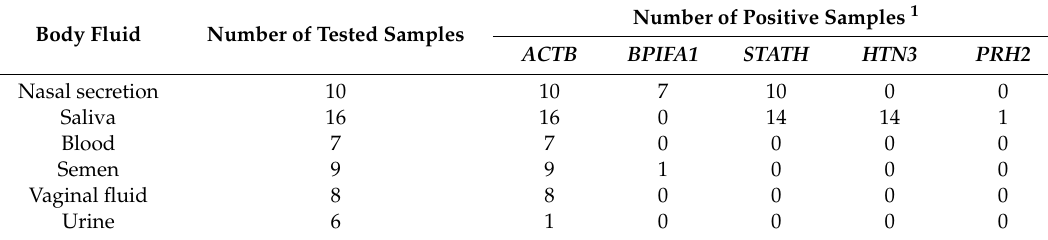
Table 3. Detectability of candidate genes for nasal secretion and saliva discrimination in various body fluids.